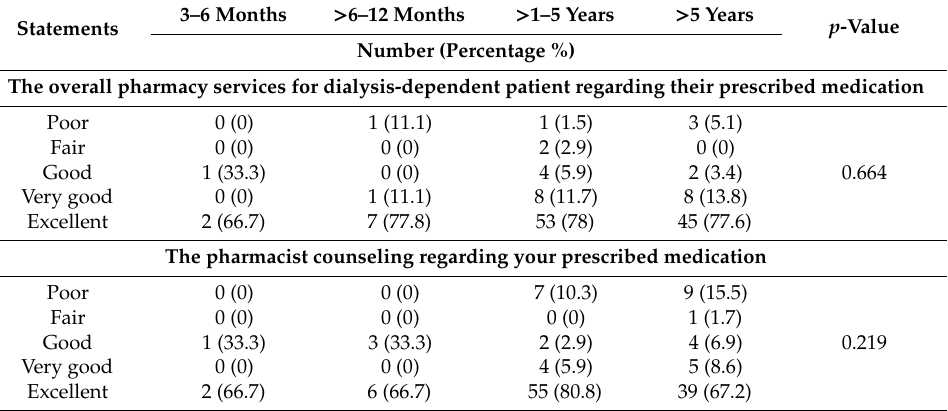
Table 6. Overall, patient satisfaction vs. years on